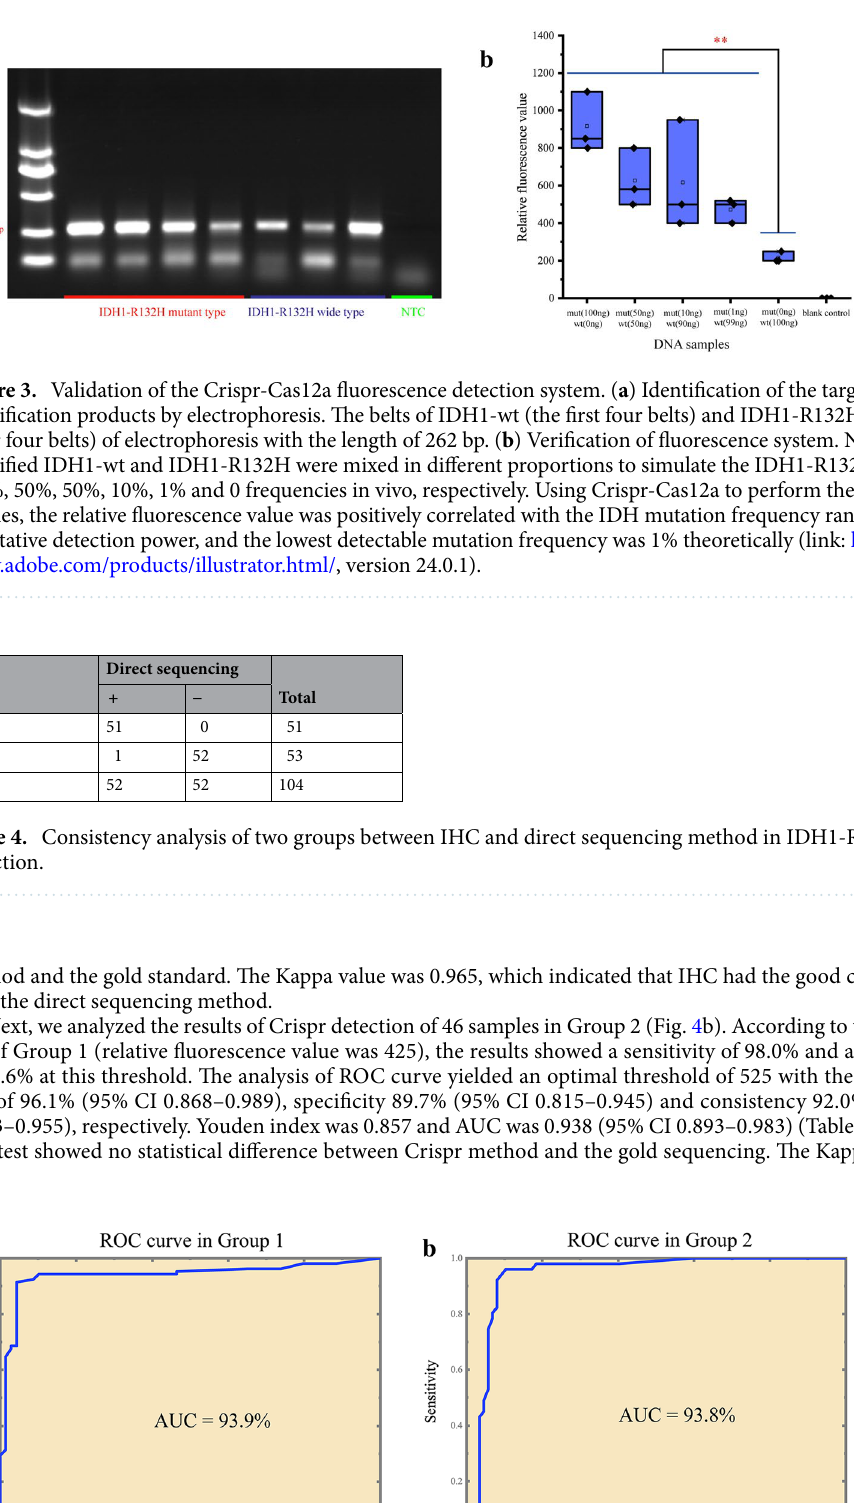
Figure 4. ROC curve of Crispr method. ( a ) ROC curve in Group 1. The value of AUC was 0.939 (95% CI 0.900–0.975); the threshold of relative fluorescence value was 425; the sensitivity, specificity and consistency rate was 91.4%, 95.7% and 93.1%, respectively. ( b ) ROC curve in Group 2. The value of AUC was 0.938 (95% CI 0.893–0.983); the threshold of relative fluorescence value was 525; the sensitivity, specificity and consistency rate was 96.1%, 89.7% and 92.0%, respectively (link: https:// www. origi nlab. com/, version OriginPro